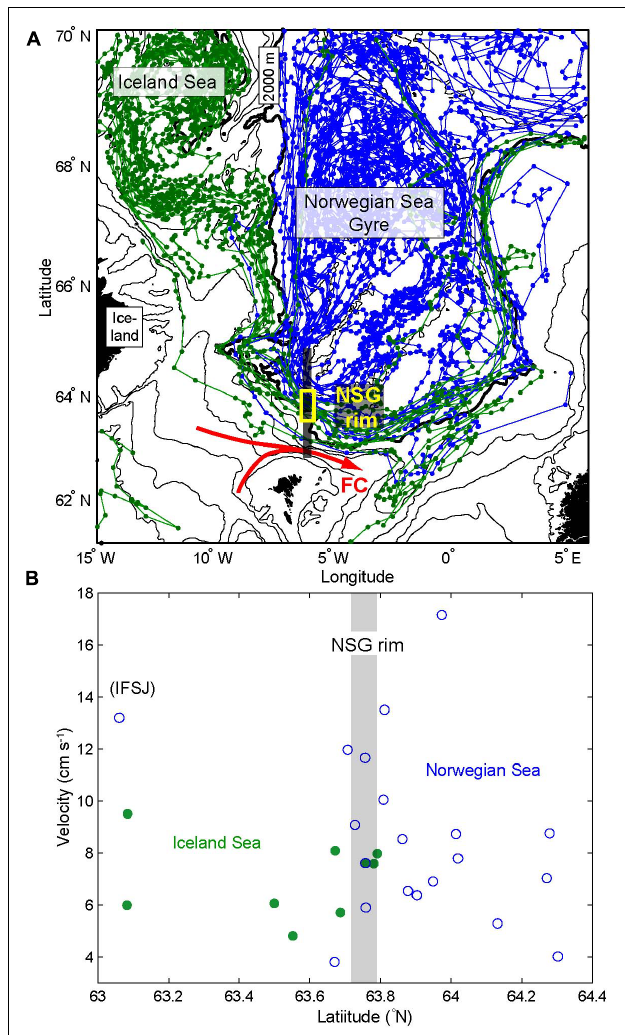
FIGURE 3 | Argo floats. (A) Drift trajectories of all available floats which have occupied the Iceland Sea (green) and the Norwegian Sea (blue), respectively. The semi-transparent black line represents Section N, the yellow rectangle shows the location of the NSG rim and the red arrow outlines the Faroe Current (FC). (B) Current velocities ( y -axis) of all the floats crossing Section N, from the Iceland Sea (green) and the Norwegian Sea (blue), respectively. The drift velocities are obtained by interpolating spatially onto this